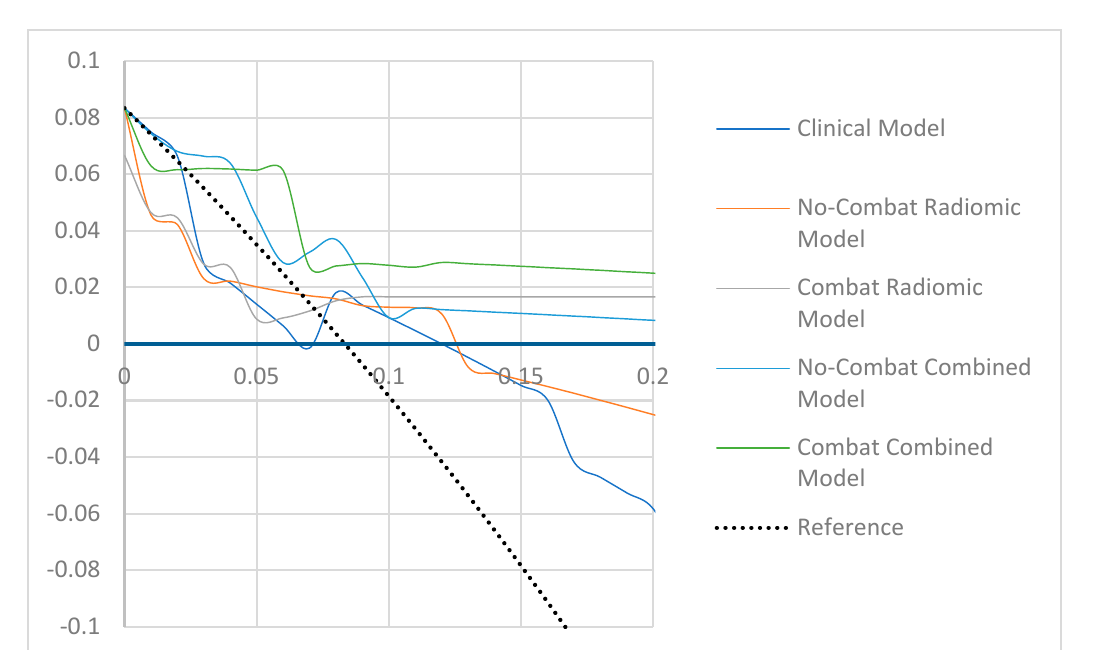
Figure 3. Decisional curve analysis for each model in the testing cohort. The analysis of inter-observer variability showed a moderate variability in delineations, with a median DICE coefficient of 0.74 (range 0.41–0.99). The application of the combined prediction model with the ComBat harmonization method provided satisfactory results with an AUC of 0.82 ( p = 0.002) and a sensitivity of 80.0%, a specificity of 90.0%, and a